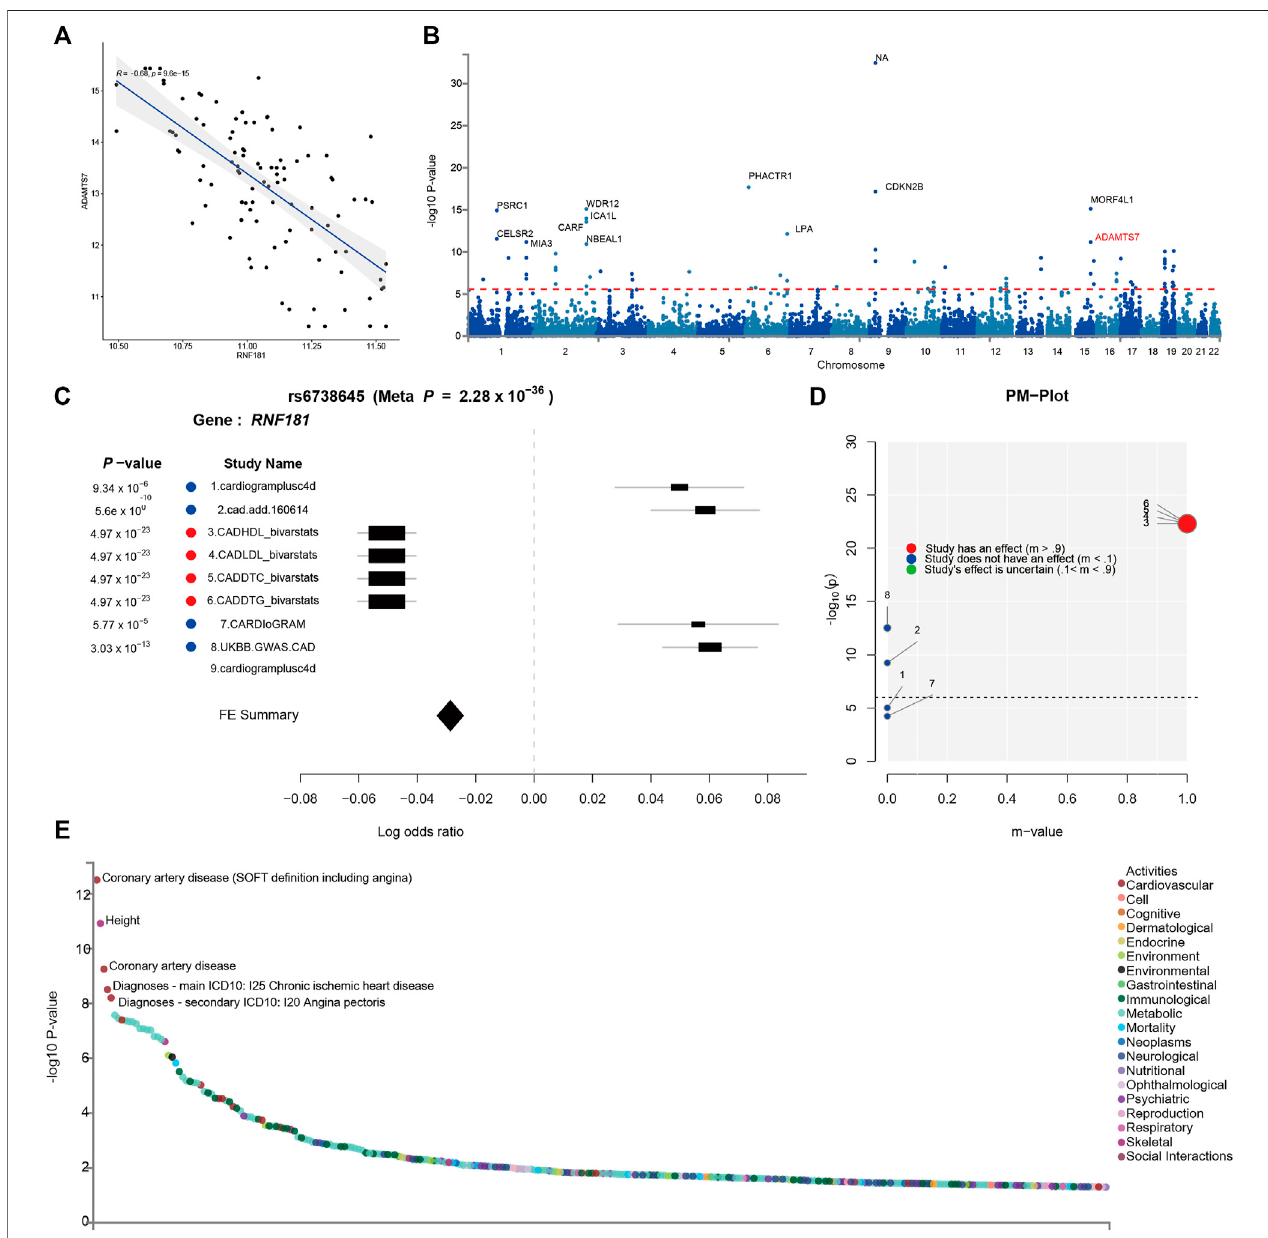
FIGURE 4 | Identi fi cation of risk variants at the RNF181 locus in the cohort and in genome-wide association studies (GWAS). The SNP locus rs6738645 in the RNF181 chromosome region was related to coronary artery disease (CAD). (A) Scattered dot plot displaying Pearson ’ s correlation between the expression of RNF181 and the CAD risk gene ADAMST7 in the CAD cohort from the PREDICT trail ( R 2 = 0.66, p < 9.6E − 15). (B) Manhattan plot showing the top 20 SNPs in the CARDIoGRAMplusC4DGWASresultsby p -value. (C) Color-codedforestplotshowingthenormalizedeffectsizesofhearttissueexpressionforrs6738645andthe corresponding 95% con fi dence intervals presented for CARDIoGRAMplusC4D and 8 other CAD meta-analyses. (D) m -values representing the posterior probability of heart tissue-speci fi c expression and their respective p -values. (E) Dot plot of phenome-wide association studies (PheWAS) showing the expression data from GWAS ATLASfortheleadSNP(rs6738645)associatedwithclinicaltraits.Genome-widesigni fi cantexpression p -valuesareshownfortheindicatedSNPs. p < 0.05(Bonferroni corrected).